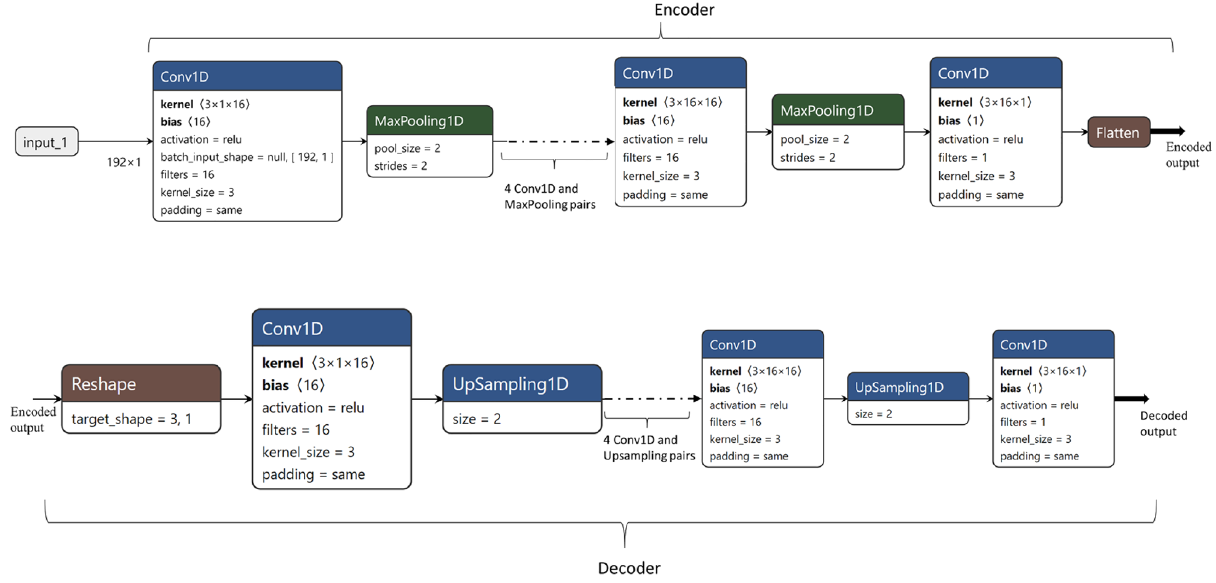
Figure 4. Convolutional auto-encoder (CAE) architecture, generated using Netron 39